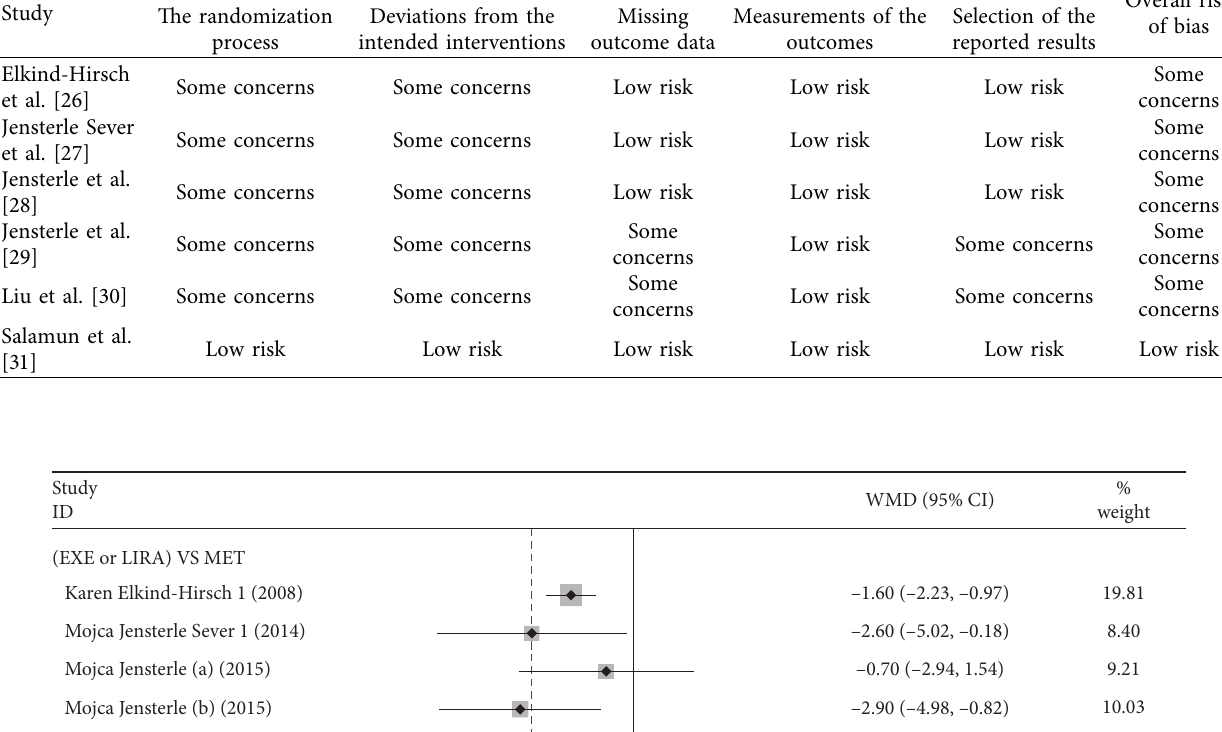
Table 3: Summary of the risk of bias for each study according to Revised Cochrane Risk of Bias Tool for Randomized Trials (RoB 2). Study